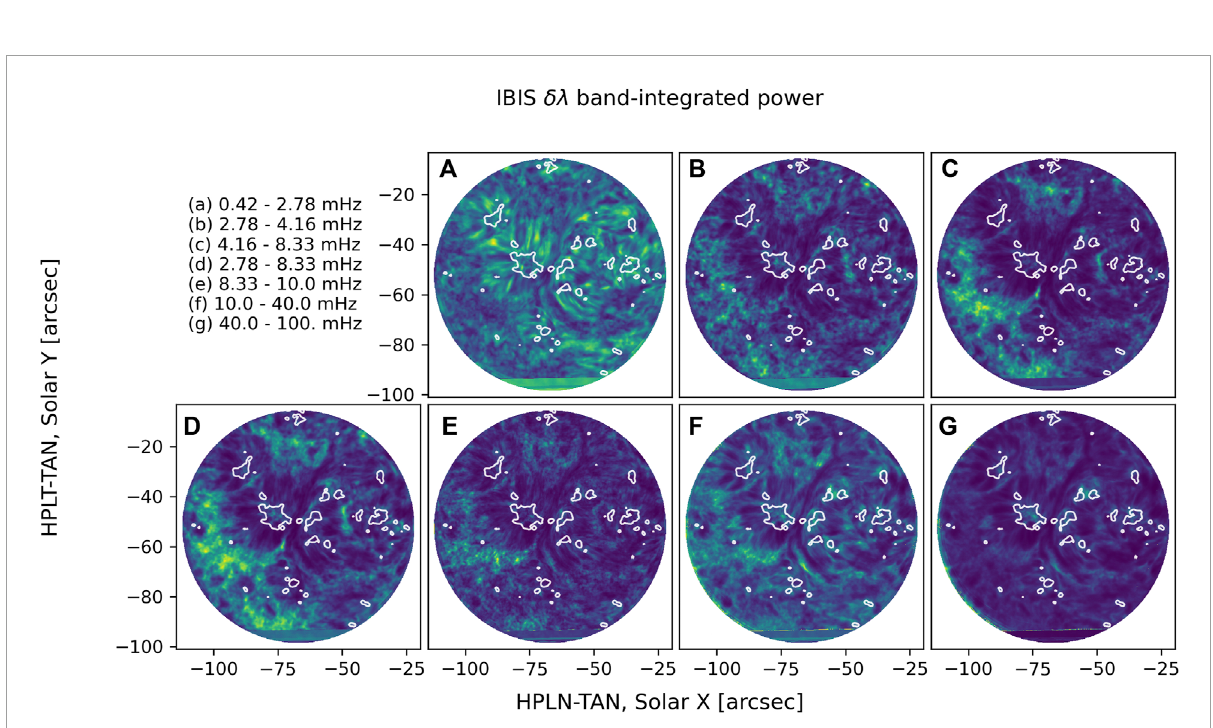
FIGURE 10 The same as Figure 9 but for the full temporal and spatial resolution IBIS H α line width. The frequency bands correspond to: (A) low frequencies; (B) 5 min oscillations; (C) 3 minute oscillations; (D) combined p-modes; (E) near-cutoff; (F) mid frequencies; (G) high